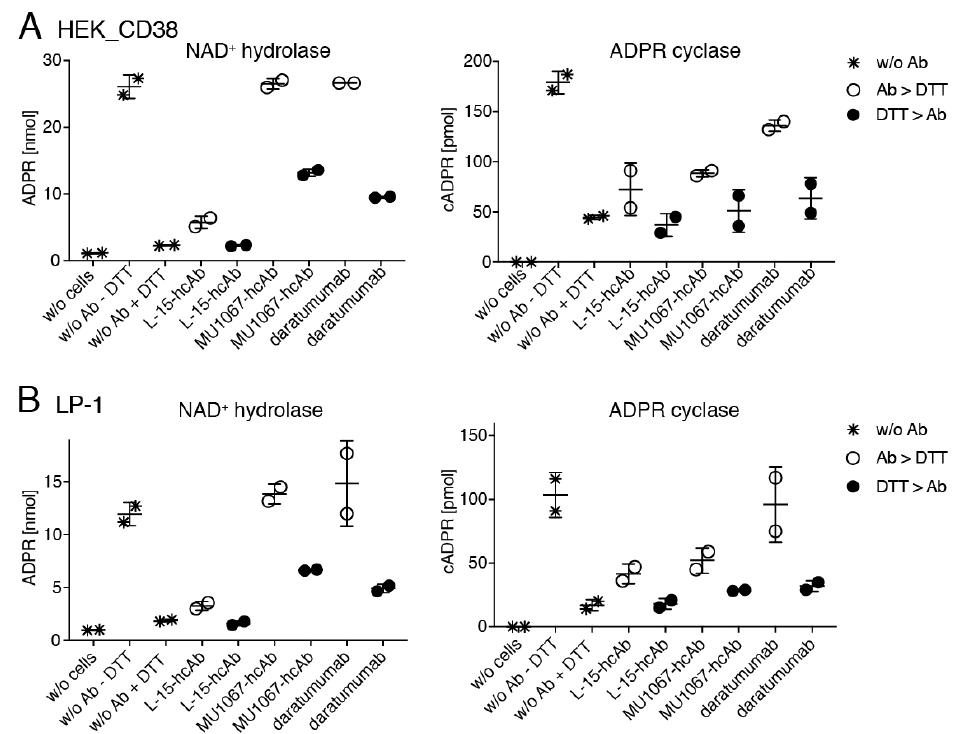
Figure 6. Daratumumab and hcAb MU1067 protect the NAD + hydrolase and ADPR cyclase activities of the CD38-expressing tumor cells from inactivation by DTT. CD38-transfected HEK cells ( A ) and LP-1 cells ( B ) were pre-incubated with 5 mM DTT for 20 min before addition of antibodies and further incubation for 15 min, or vice versa. NAD + was then added and incubation continued for 60 min at 37 ◦ C. Concentrations of ADPR and cADPR were determined by HPLC, as in Figure 1. Toxin-specific L-15-hcAb was used as